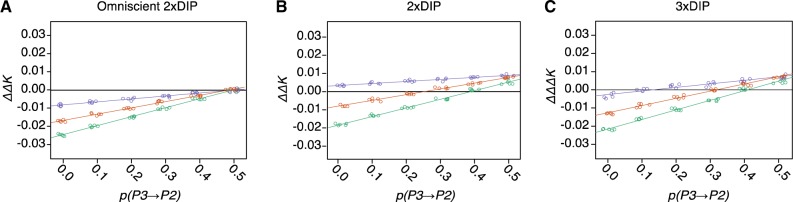
—Characterization of DIP bias under short branch conditions. Genomes were simulated with different values of p(P3⇒P2) (x axis) and different branch-length scaling factors (SF) (point colors). See figure 6 for description of SF. Purple, SF = 0.1; Orange, SF = 0.2; Green, SF = 0.3. As in figure 6, Omniscient 2×DIP (A), standard 2×DIP (B), and 3×DIP (C) were performed. Five replicate genomes were analyzed for each condition. pINT = 0.5 was used for all simulations.